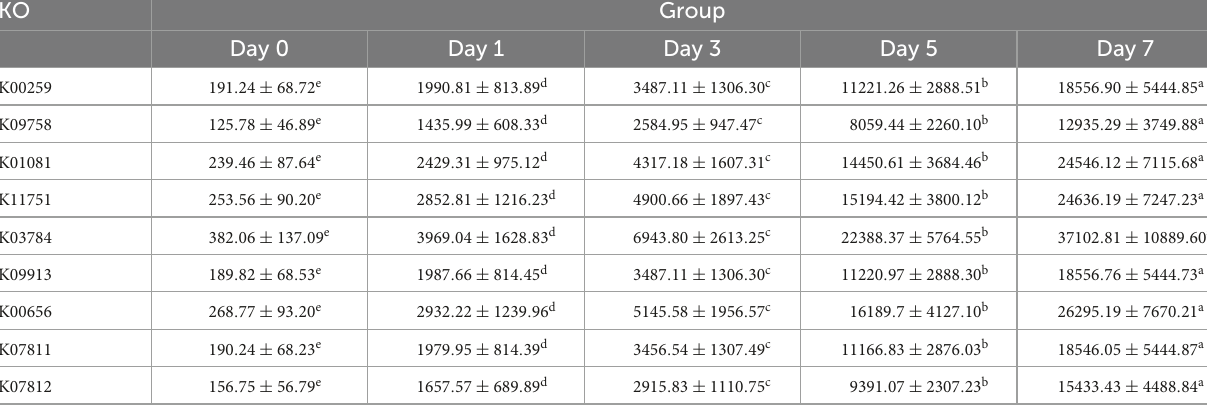
TABLE 2 The abundances of predicted functional genes in Vibrio .